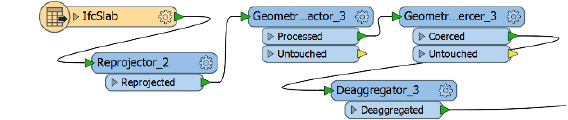
Figure 5: Algorithm of extracting IFC